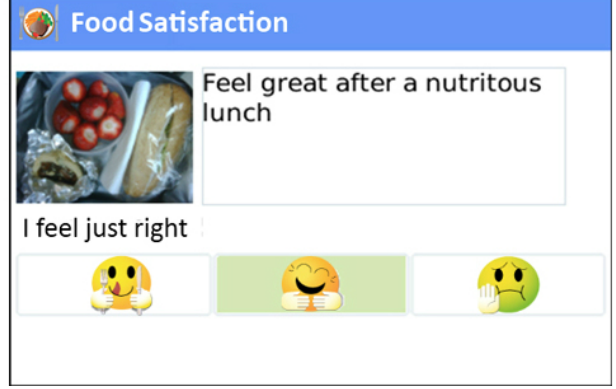
Figure 4. Satisfaction survey: at a customizable timeframe (usually 20 minutes), the program prompts for reports on satiety level (not enough, just right, too full).